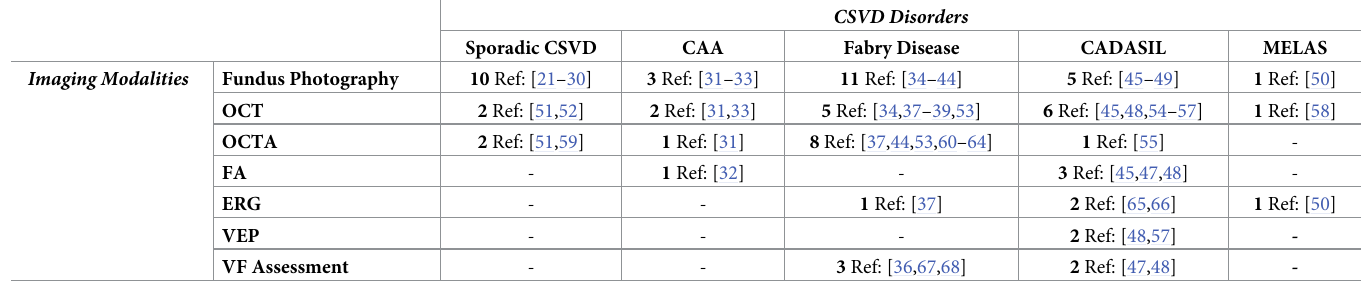
Table 2. Summary of imaging modalities and CSVD disorders for studies included in systematic